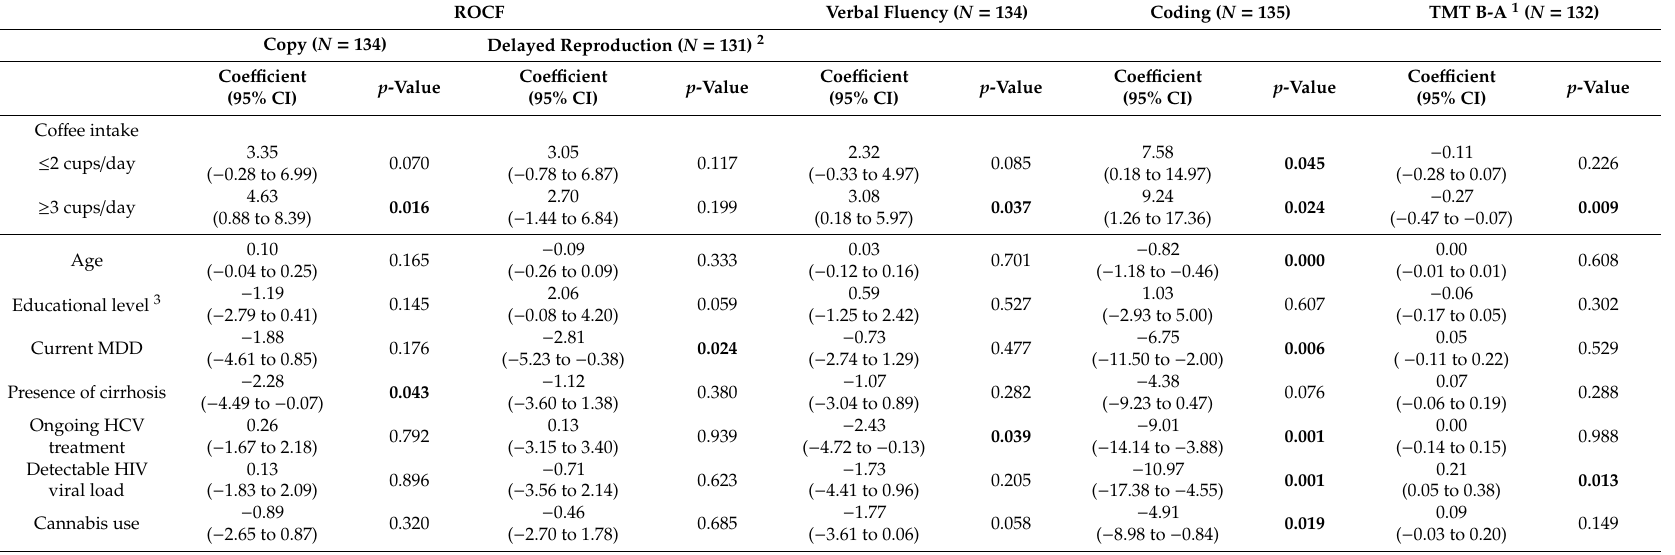
Table 2. Factors associated with neurocognitive performance in HIV-HCV coinfected patients, multivariable linear regression models, the ANRS CO13 HEPAVIH cohort and the HEPAVIH-Psy cross-sectional survey (N =